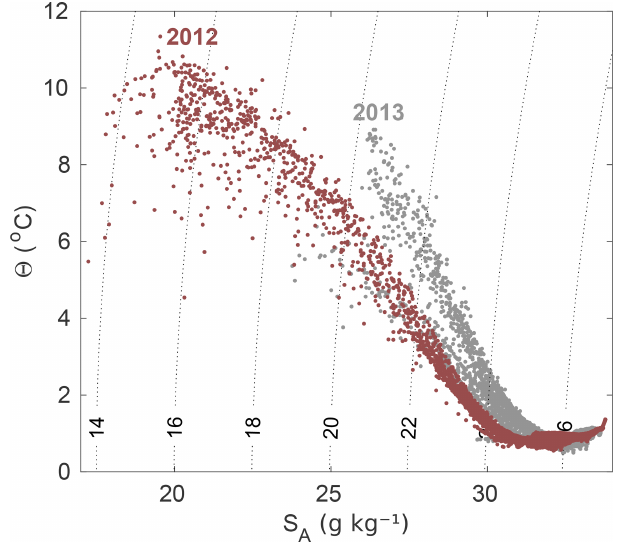
Figure 6. Conservative temperature vs. absolute salinity diagram, showing the different water properties in Saqqarleq Fjord during fieldwork in July 2012 (red) and 2013 (grey). Isopycnals of sigma– theta are plotted as dotted near-vertical